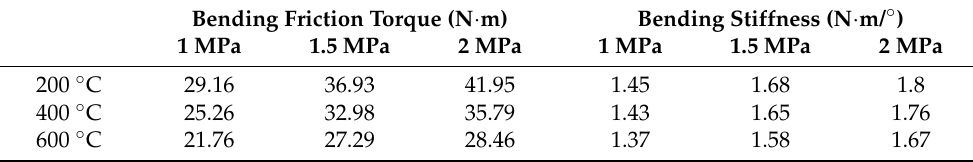
Table 4. Correction value of bending